Question: Condense the content of this figure into a single sentence.
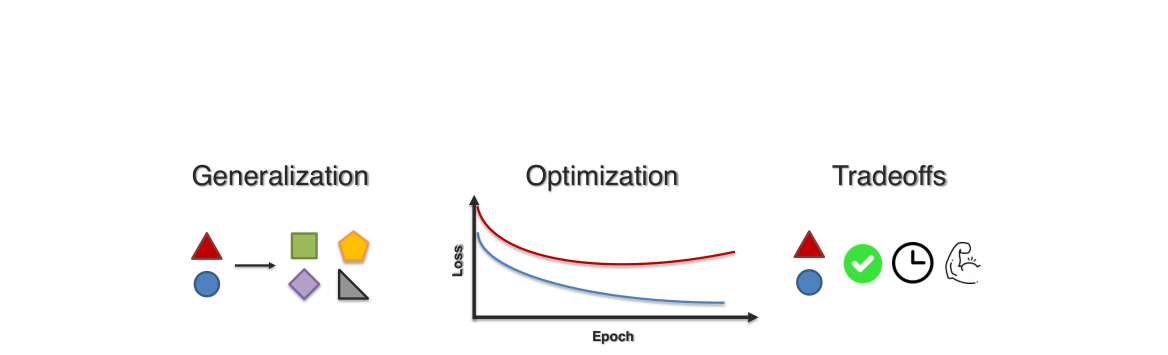
Answer: 20: Studying the multimodal learning process involves understanding (1) generalization across modalities and tasks, (2) optimization for balanced and efficient training, and (3) tradeoffs between performance, robustness, and complexity in the real-world deployment of multimodal models.